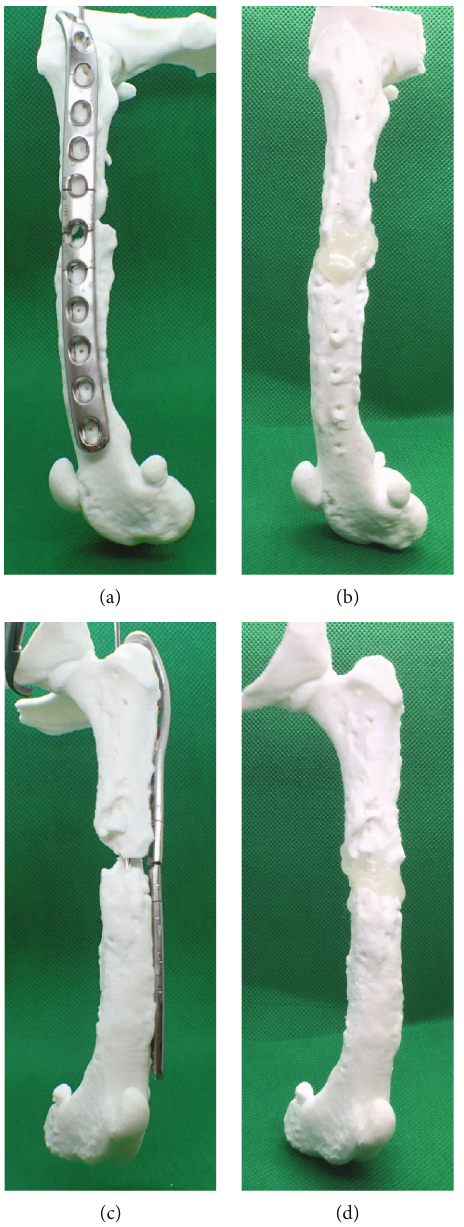
Figure 2: A model created with a three-dimensional printer. The alignment of the femur was con fi rmed by reproducing the femur with the plate and screws fi xed at the time of the previous surgery. Although di ffi cult to divide in the lateral view, the distal fracture fragments can be observed to be fi xed outward in the anterior-posterior view. (a) Lateral view with the plate fi xed. (b) Lateral view without the plate. (c) Anterior-posterior view with the plate fi xed. (d) Anterior-posterior view without the